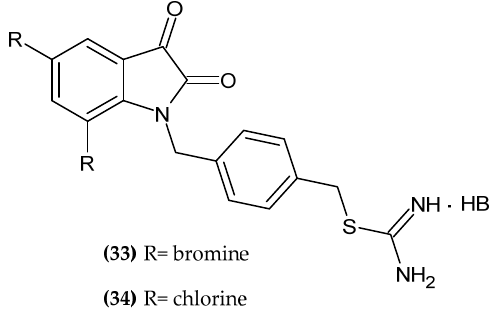
Figure 7. Indole derivatives with anti-melanoma